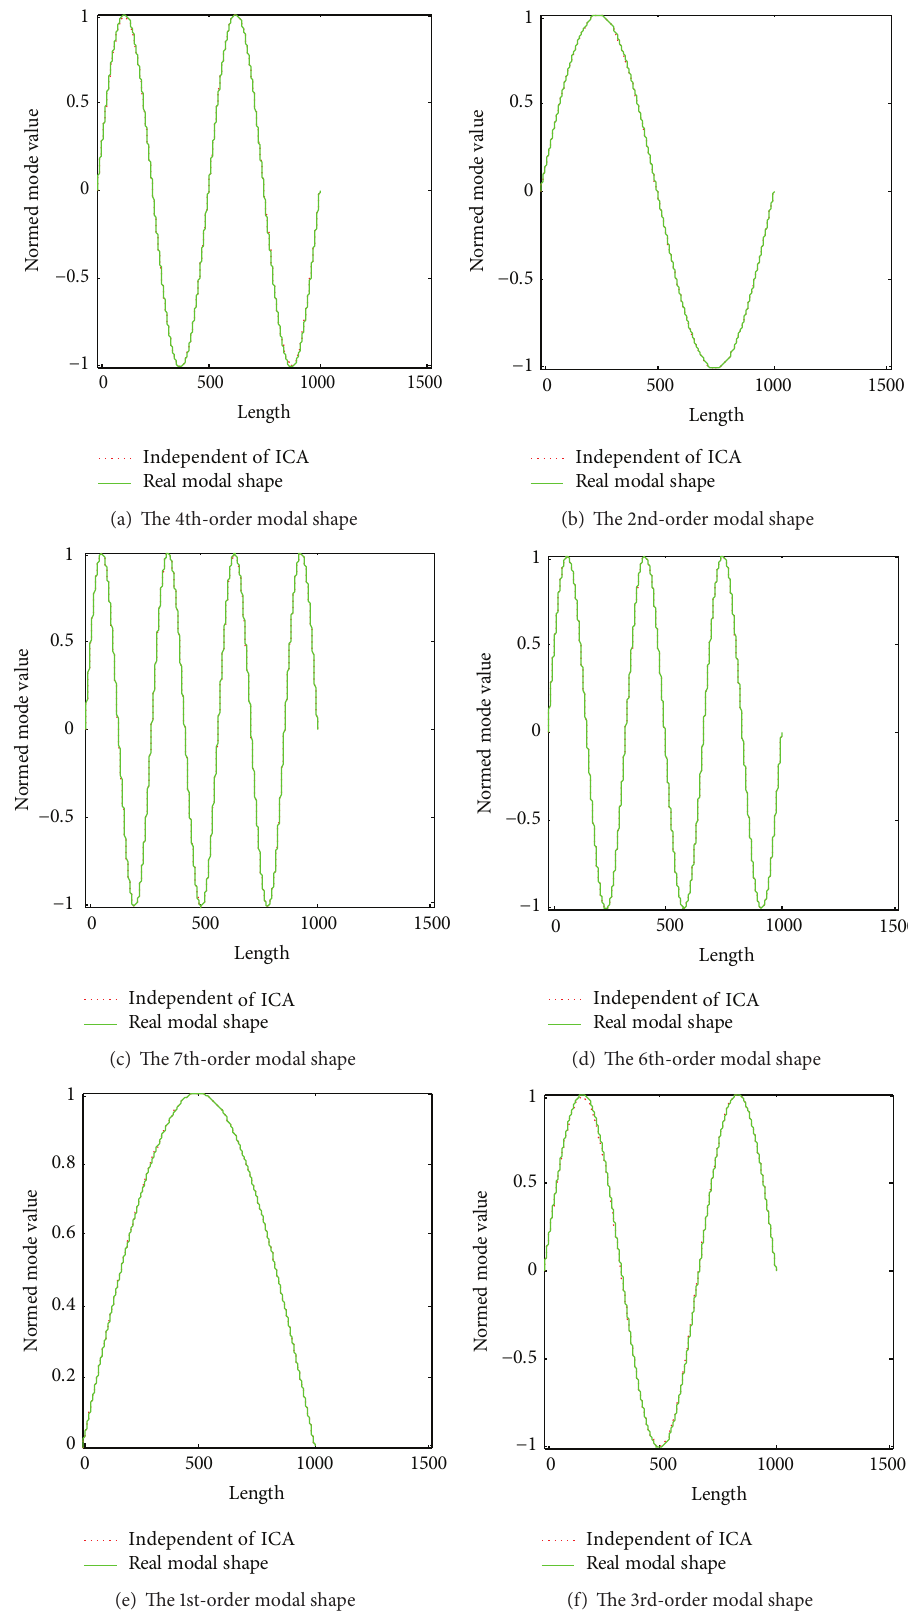
Figure 4: Modal shape comparison between FEA and separating vector by maximization kurtosis with gradient descent